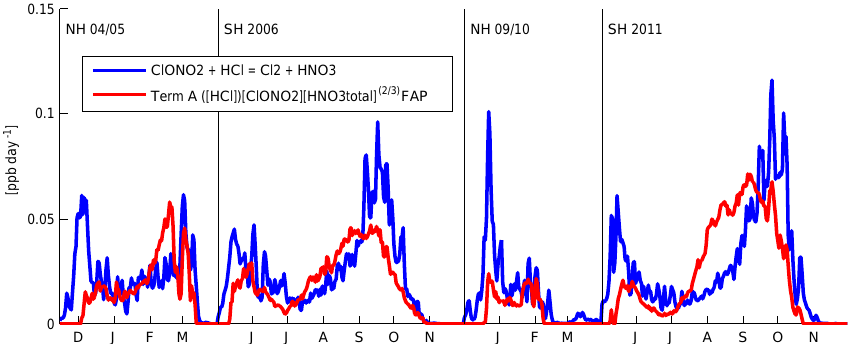
Figure 7. Fit of term A for the Arctic winter 2004/2005, the Antarctic winter 2006, the Arctic winter 2009/2010 and the Antarctic winter 2011 at 54hPa. Vortex-averaged reaction rate modeled by ATLAS for the reaction HCl + ClONO 2 (blue) and the fitted term A (red). Tick marks on the horizontal axis show start of months.